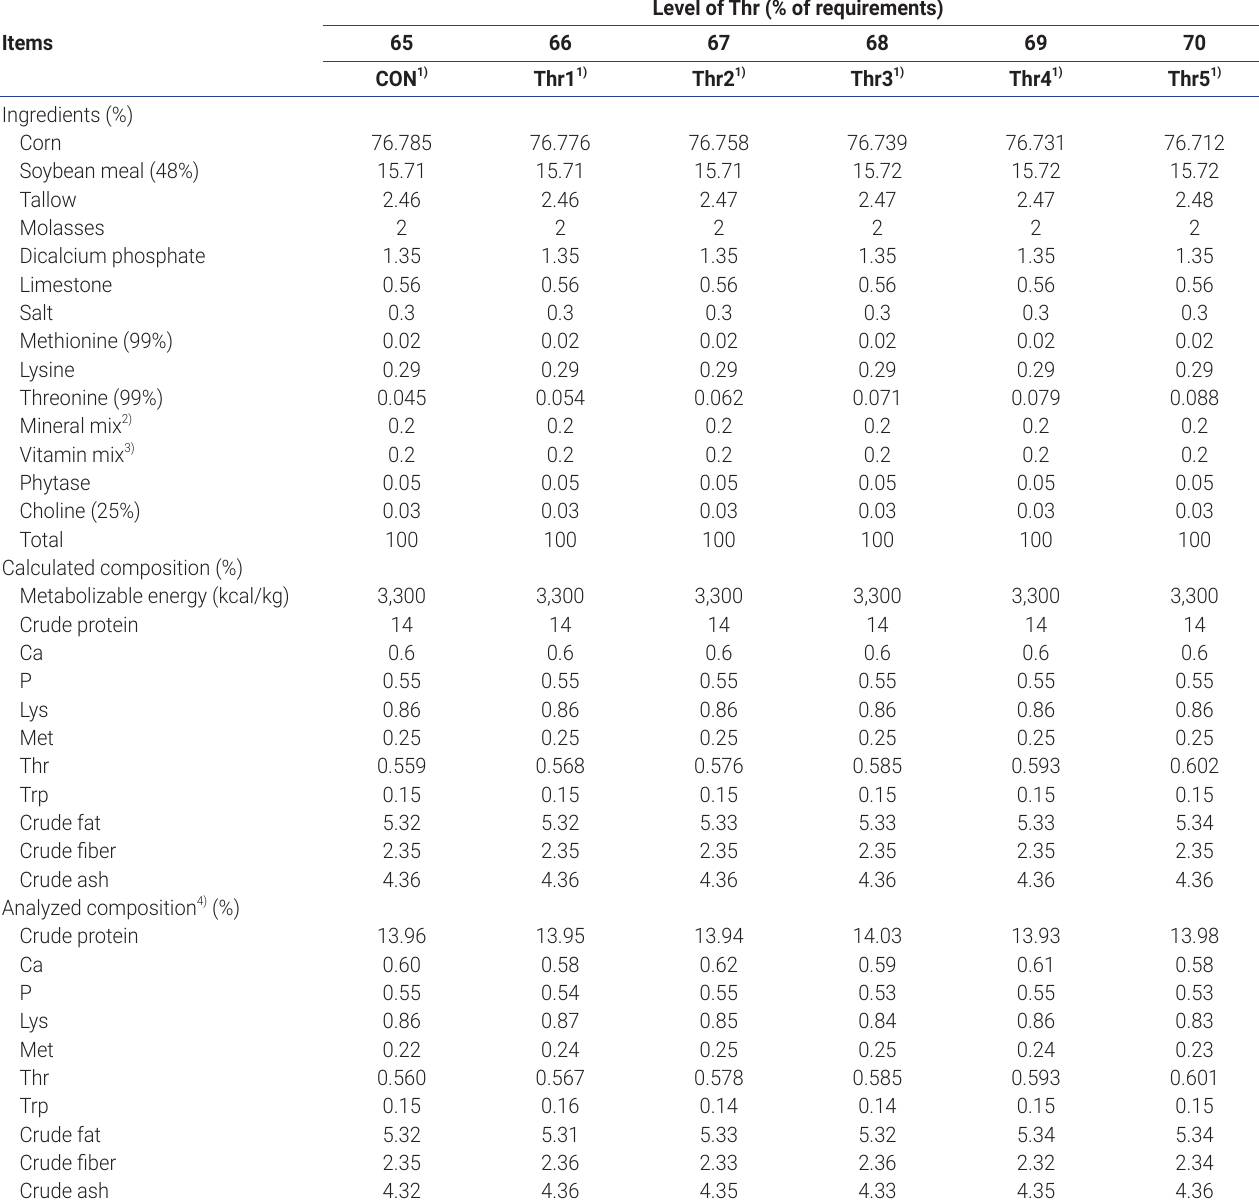
Table 1. Ingredient and nutrient composition of experimental diets for finishing pigs (as